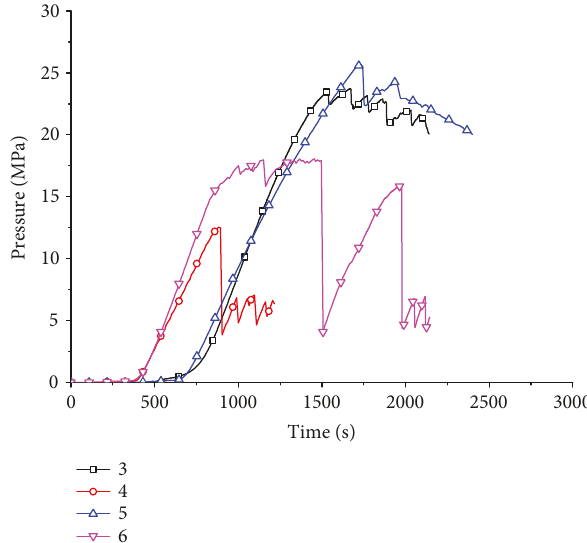
Figure 21: Pressure curves in the core fracturing process.